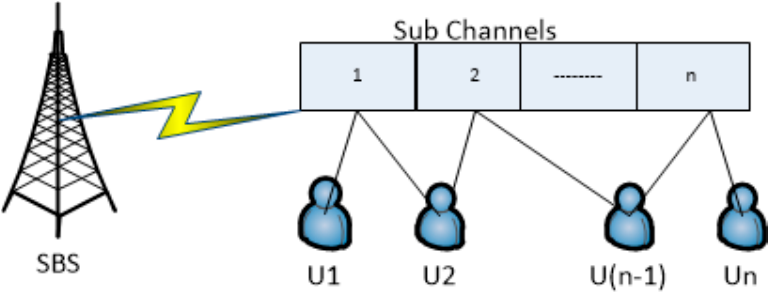
Figure 3. Sub channel assignment .